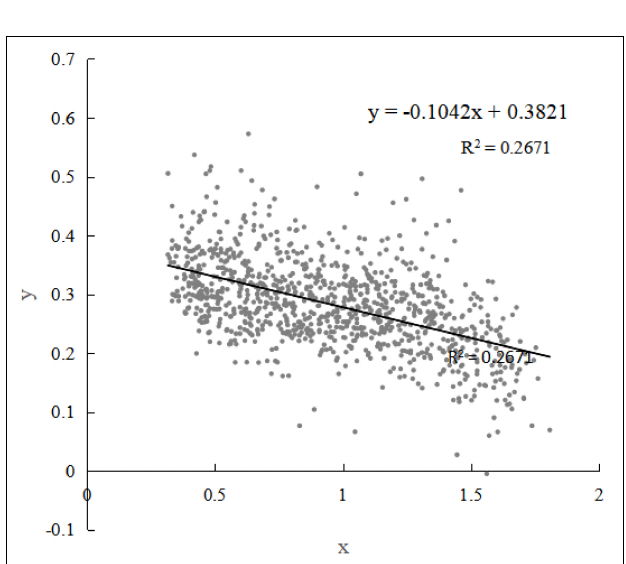
FIGURE 5 | Fitting curve of the correction coefficients k and b in the daily long-wave net radiation algorithm.